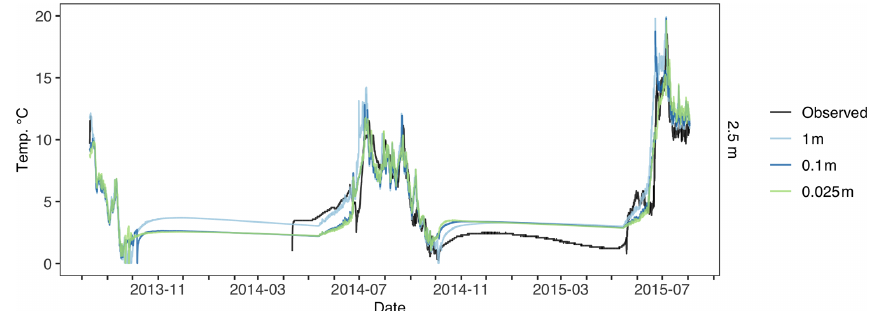
Figure D2. Atqasuk 2.5m water temperature across different water vertical resolution simulations. Observed water temperature is in black, 1m vertical resolution is in light blue, 0.1m vertical resolution is in blue, and 0.025m vertical resolution is in green. Note that 0.1 and 0.025m overlap for most of the time series.